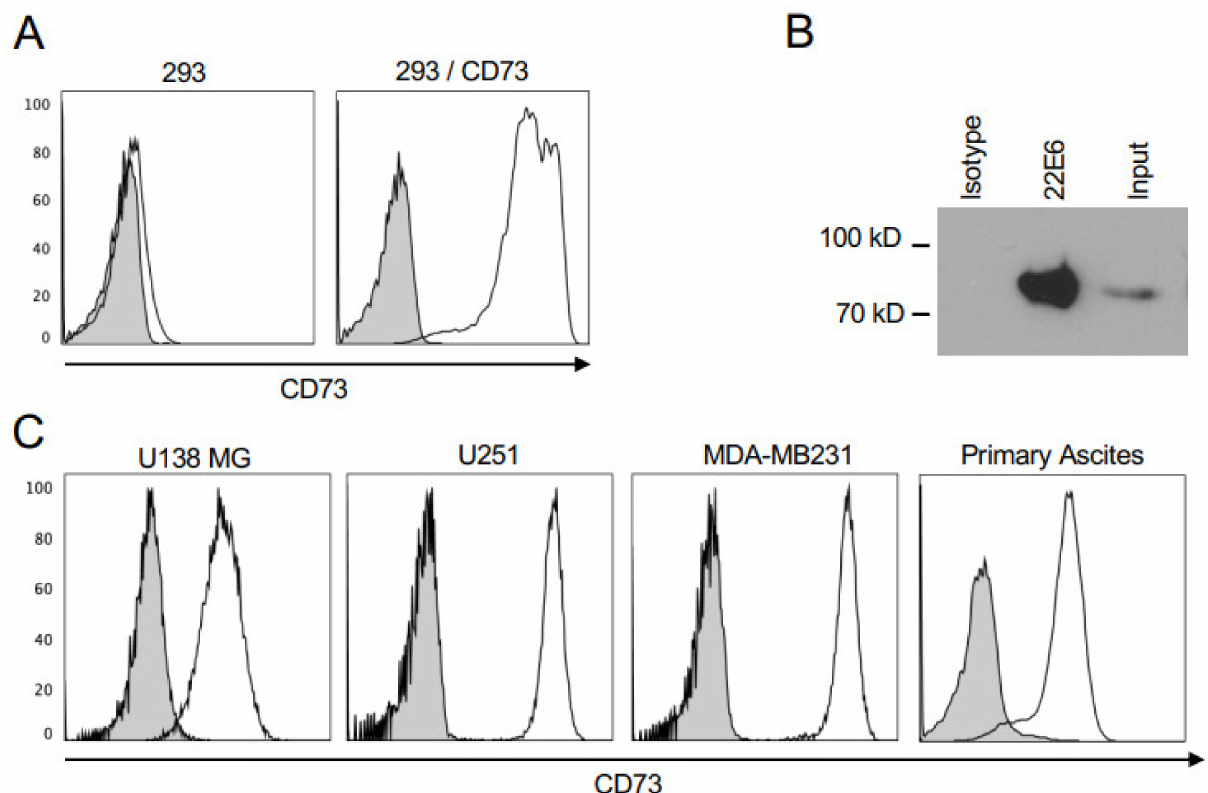
Figure 1. 22E6 is CD73-specific. ( A ) 22E6 binds to HEK293 cells stably transfected with a CD73 ex- pression plasmid (293/CD73) but not to parental HEK293 cells (293). ( B ) 22E6 specifically precipitates CD73 from lysates. ( C ) 22E6 binds to various permanent cancer cell lines and cells isolated from primary ascites. Plain histograms in ( A , C ) = isotype control